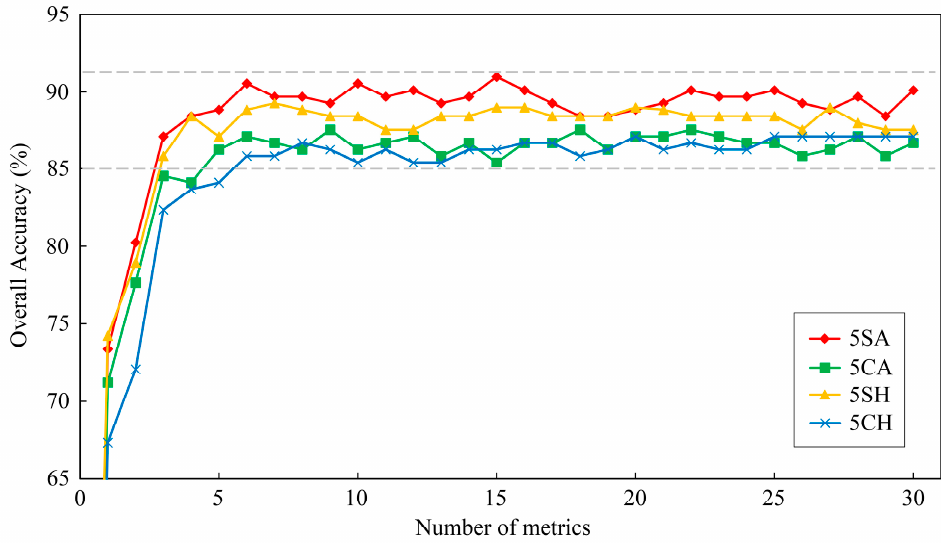
Figure 7. Evolution of overall classification accuracy with changing number of metrics. 5SA = Five tree-species classification using all metrics (LiDAR and sunlit hyperspectral metrics); 5CA = Five tree-species classification using all metrics (LiDAR and crown hyperspectral metrics); 5SH = Five tree-species classification using sunlit hyperspectral metrics; 5CH = Five tree-species classification using crown hyperspectral metrics.